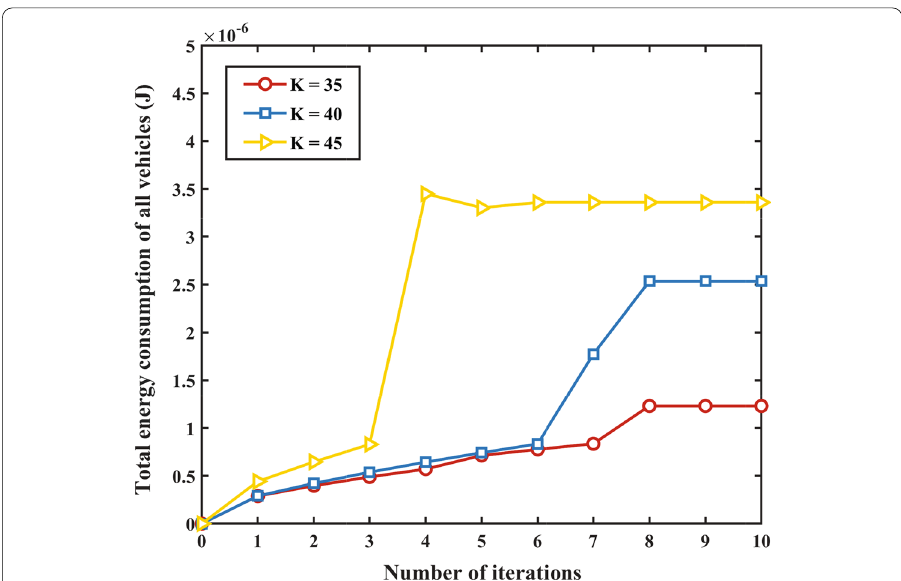
Fig. 3 Convergence behaviour for the total energy consumption of all vehicles versus the number of vehicles, B L 20 MHz, S k 0.5, and B U k 20 MHz for all k ∈ = = =